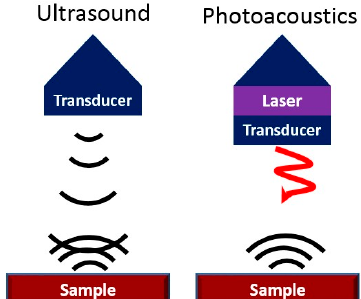
Figure 3. Acoustic Modalities. Ultrasound uses echoes to create contrast (“sound in/sound out”). Photoacoustics is “light in/sound out” and is based on thermal expansion of the target tissue or contrast agent.